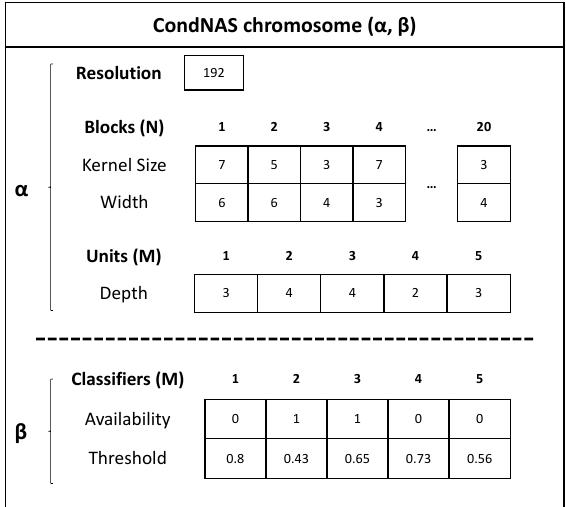
Figure 3. CondNAS chromosome with 56